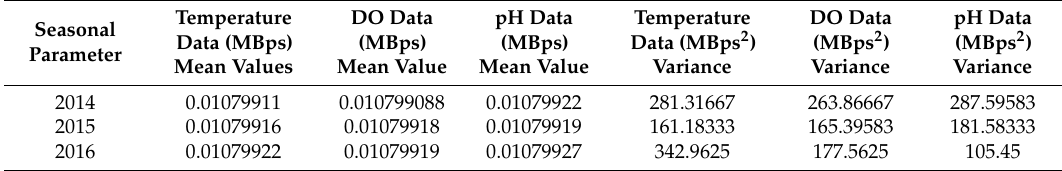
Figure 1. Geographical location of sampling site ( Jungnangcheon stream).